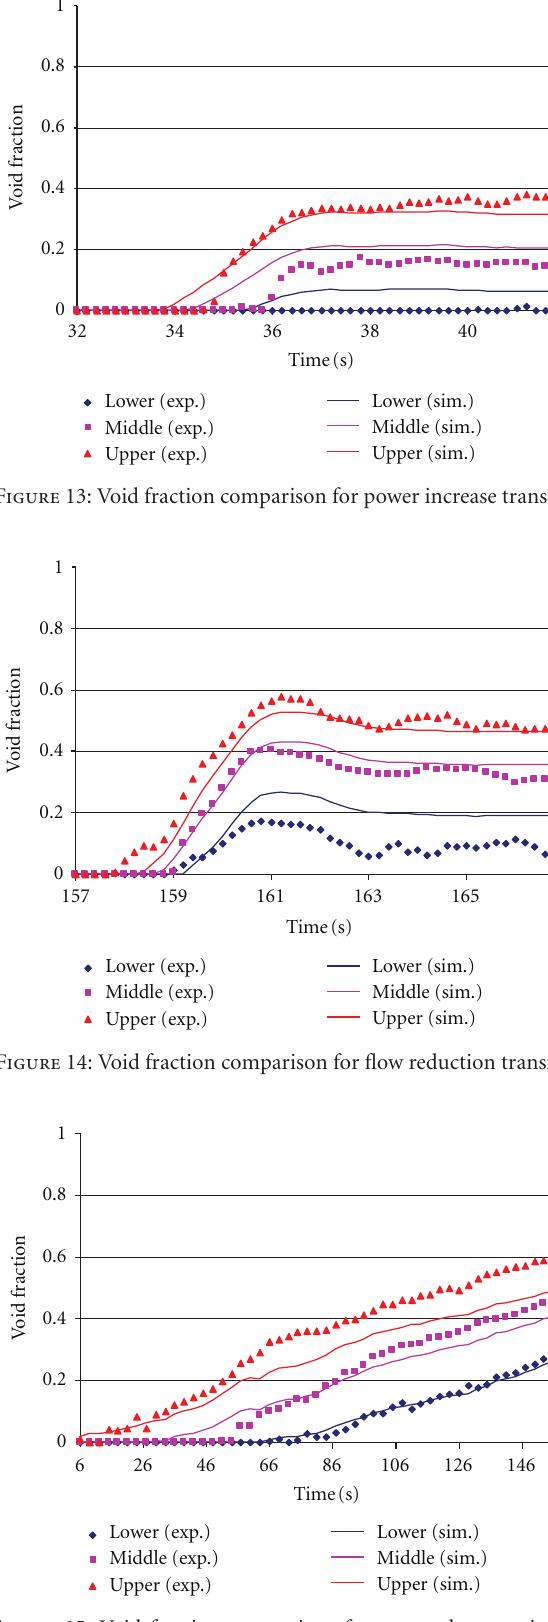
Figure 15: Void fraction comparison for power depressurization